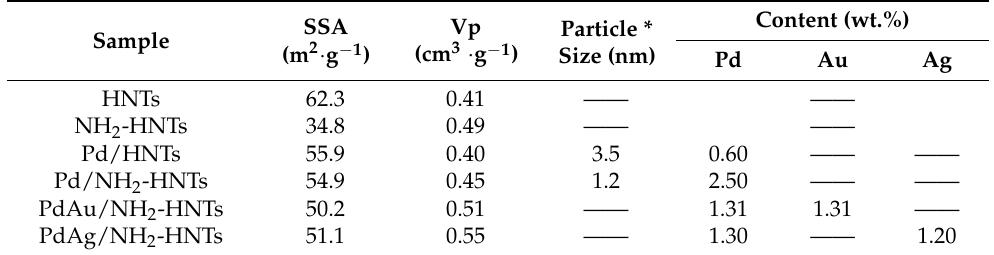
Table 1. The SSAs, pore volumes and mean sizes of metal particles; and the metal contents of catalysts.